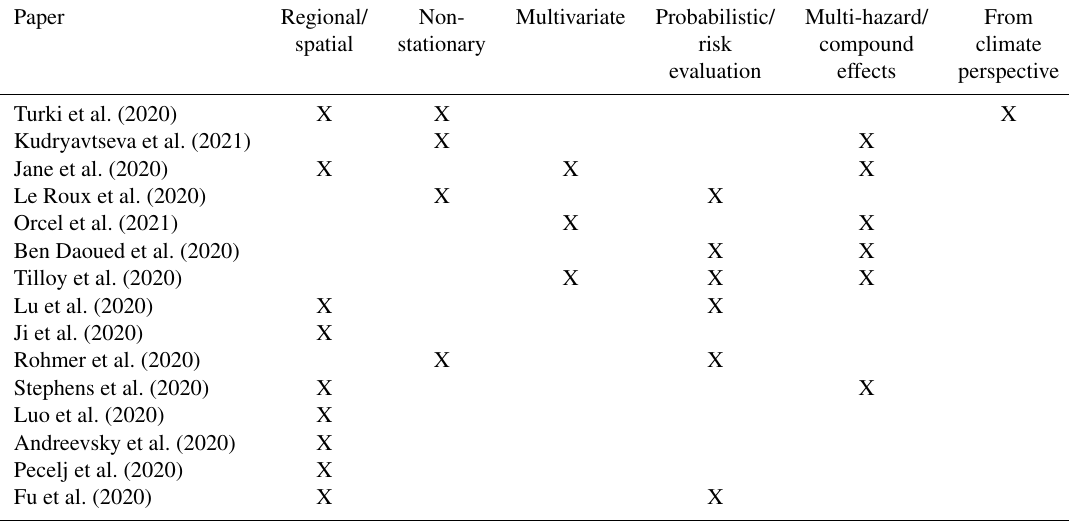
Table 1. The special issue thematic areas.